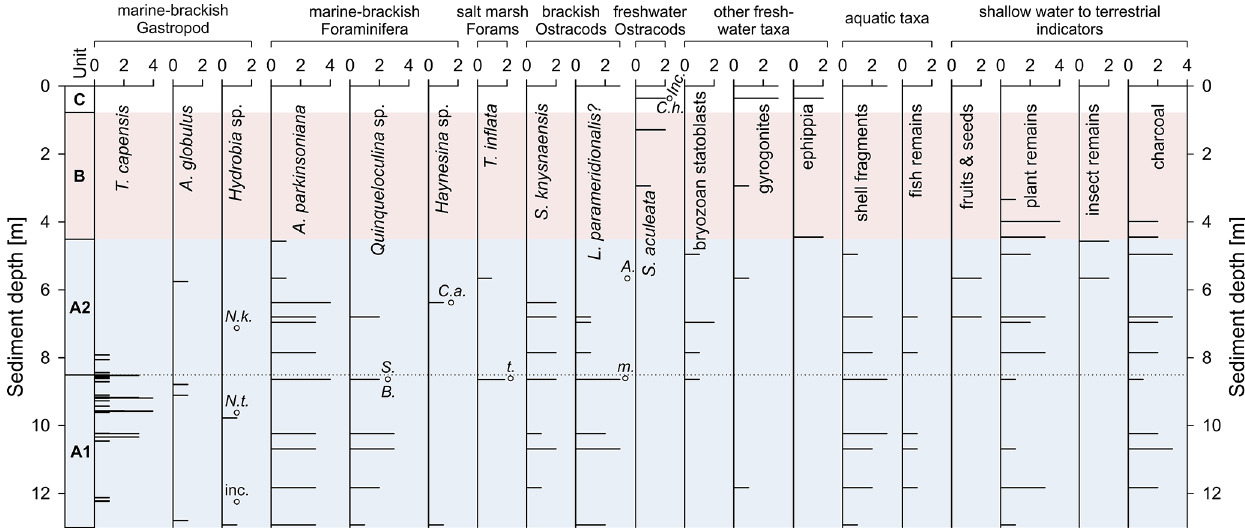
Figure 5. Distribution of micropaleontological taxa and charcoal in core VOV16. Units are based on distribution of micropaleontological taxa and lithological characteristics. Additional macrofossils were picked from the lowest part of the core where they are relatively abundant. All abundances are given semi-quantitatively (0 – absent, 1 – rare, 2 – common, 3 – abundant, 4 – very abundant). Single occurrences of taxa are indicated by empty circles and abbreviated name ( Nassarius kraussianus , Natica tecta , Bolivina sp., Spirillina sp., Cribroelphidium articulatum , trochamminid foraminifer , Aglaiella , myodocopid ostracod , Cyprilla humilis